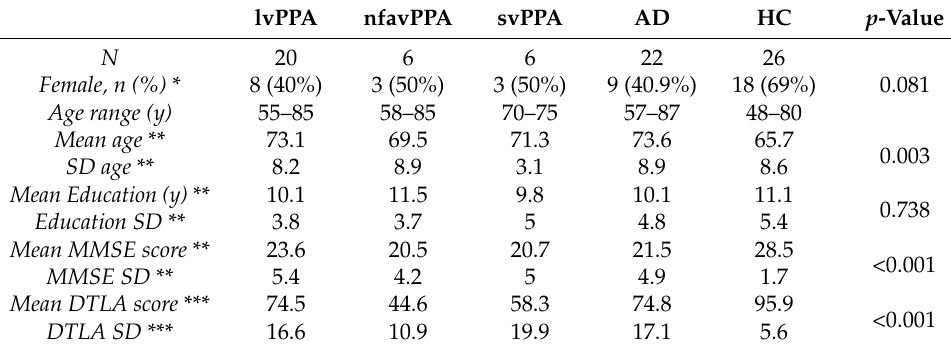
Table 1. Demographic features of the groups of